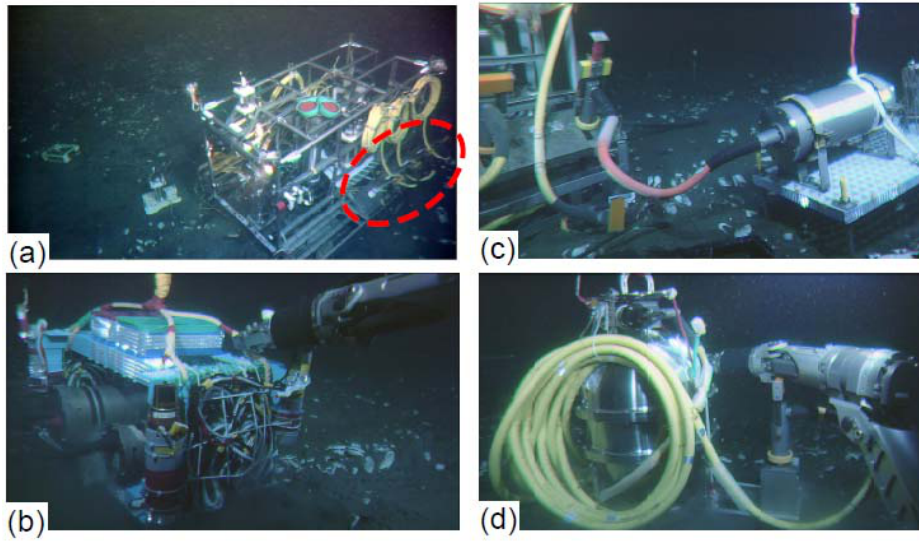
Figure 2. (a) Photograph of the renewed Hatsushima Observatory. Red dashed line shows serial ports. (b) An ocean bottom electromagnetometer set up near the Hatsushima Observatory by the ROV Hyper Dolphin. (c) An ocean bottom differential pressure gauge (DPG) system connected to the serial port. (d) Photograph of an ocean bottom gravimeter during emplacement